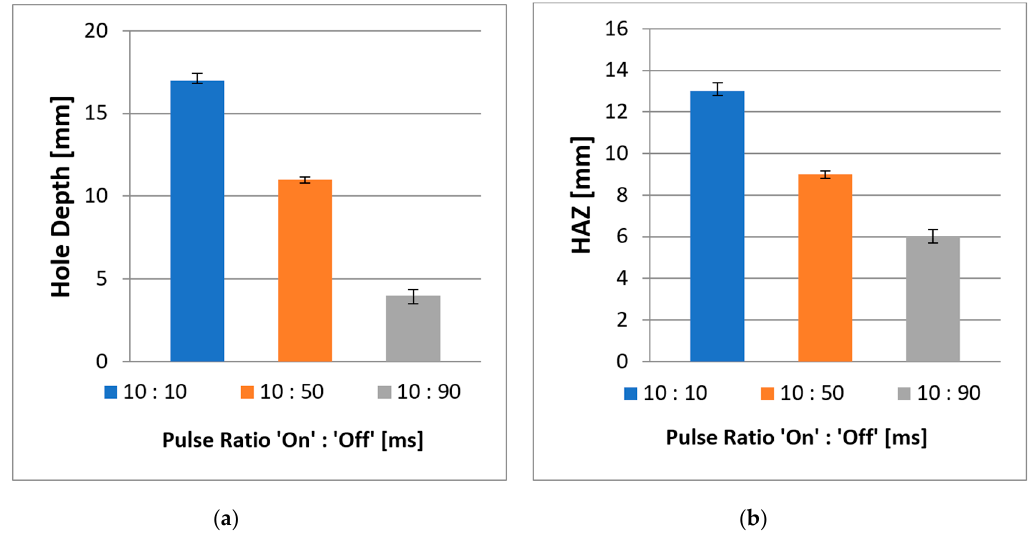
Figure 17. E ff ect of a modulated laser beam on ( a ) hole depth and ( b )